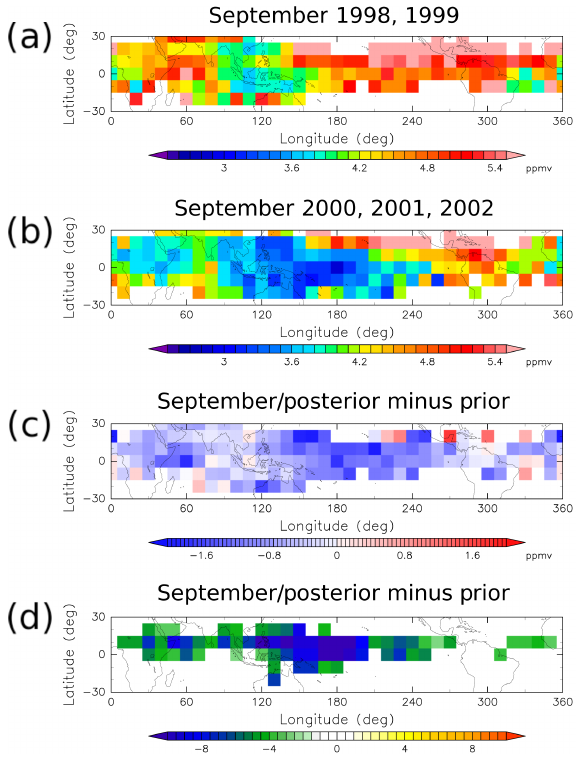
Figure 6. The same as Fig. 5 except that the ensemble mean values of SMR min are illustrated on a bin-by-bin basis (SMR(LCP ∈ j )). The test statistic shown in (d) is T 2 of Appendix A2. See Appendix for the details.